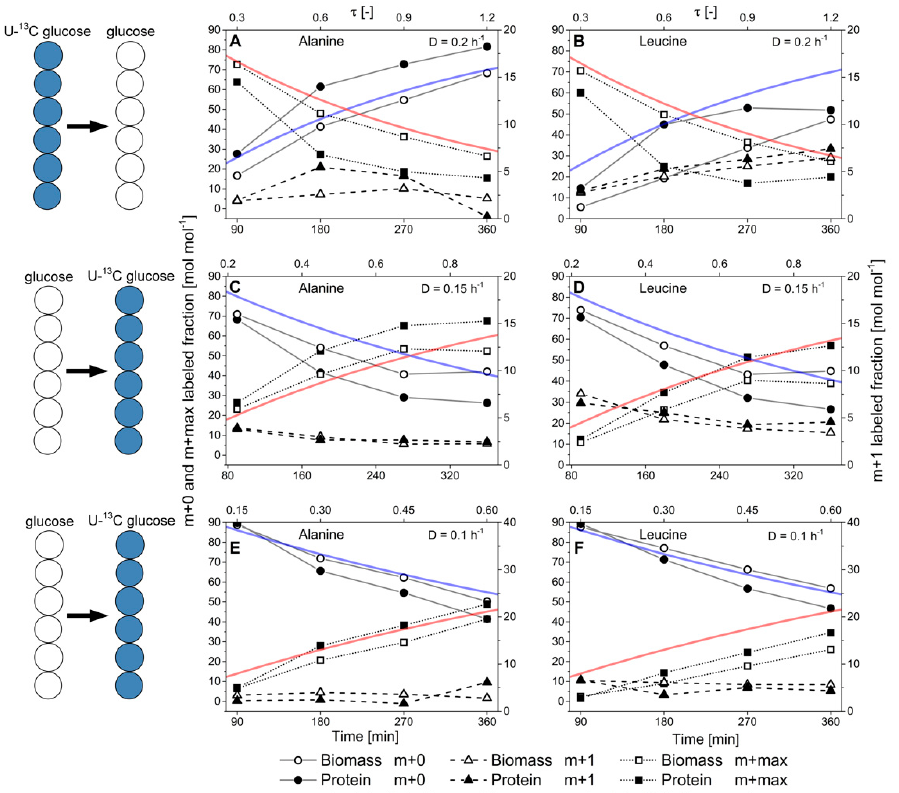
Figure 10. Labeling dynamics in H. polymorpha RB11 conphys in metabolic steady-state and isotopic nonstationary state at different dilution rates. Depicted are the molar fractions of the m + 0, m + 1, and m + max mass isotopomers into the m-57 fragment of pyruvate-borne alanine and leucine upon the change from uniformly-labeled 13 C glucose to naturally labeled glucose or vice versa. Labeling dynamics of ( A ) alanine and ( B ) leucine under non-stationary isotopic conditions upon the change from 100% (mol/mol) U- 13 C glucose to 100% (mol/mol) naturally labeled glucose at a dilution rate of D = 0.2 h − 1 . Labeling dynamics of ( C ) alanine and ( D ) leucine under non-stationary isotopic conditions upon the change from 100% (mol/mol) naturally labeled glucose to 100% (mol/mol) U- 13 C glucose at a dilution rate of D = 0.15 h − 1 . Labeling dynamics of ( E ) alanine and ( F ) leucine under non-stationary isotopic conditions upon the change from 100% (mol/mol) U- 13 C glucose to 100% (mol/mol) naturally labeled glucose at a dilution rate of D = 0.1 h − 1 . M + 0 denotes the completely unlabeled carbon backbone, m + 1 the single-labeled amino acid backbone, and m+max the fully labeled backbone with 13 C-isotopes. For alanine and leucine, m+max corresponds to the mass isotopomers m + 4 and m + 5, respectively. τ [-] represents the normalized residence